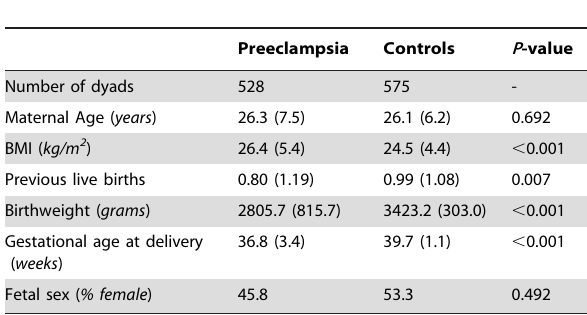
Table 1. Maternal and fetal characteristics of pregnancies diagnosed with preeclampsia and